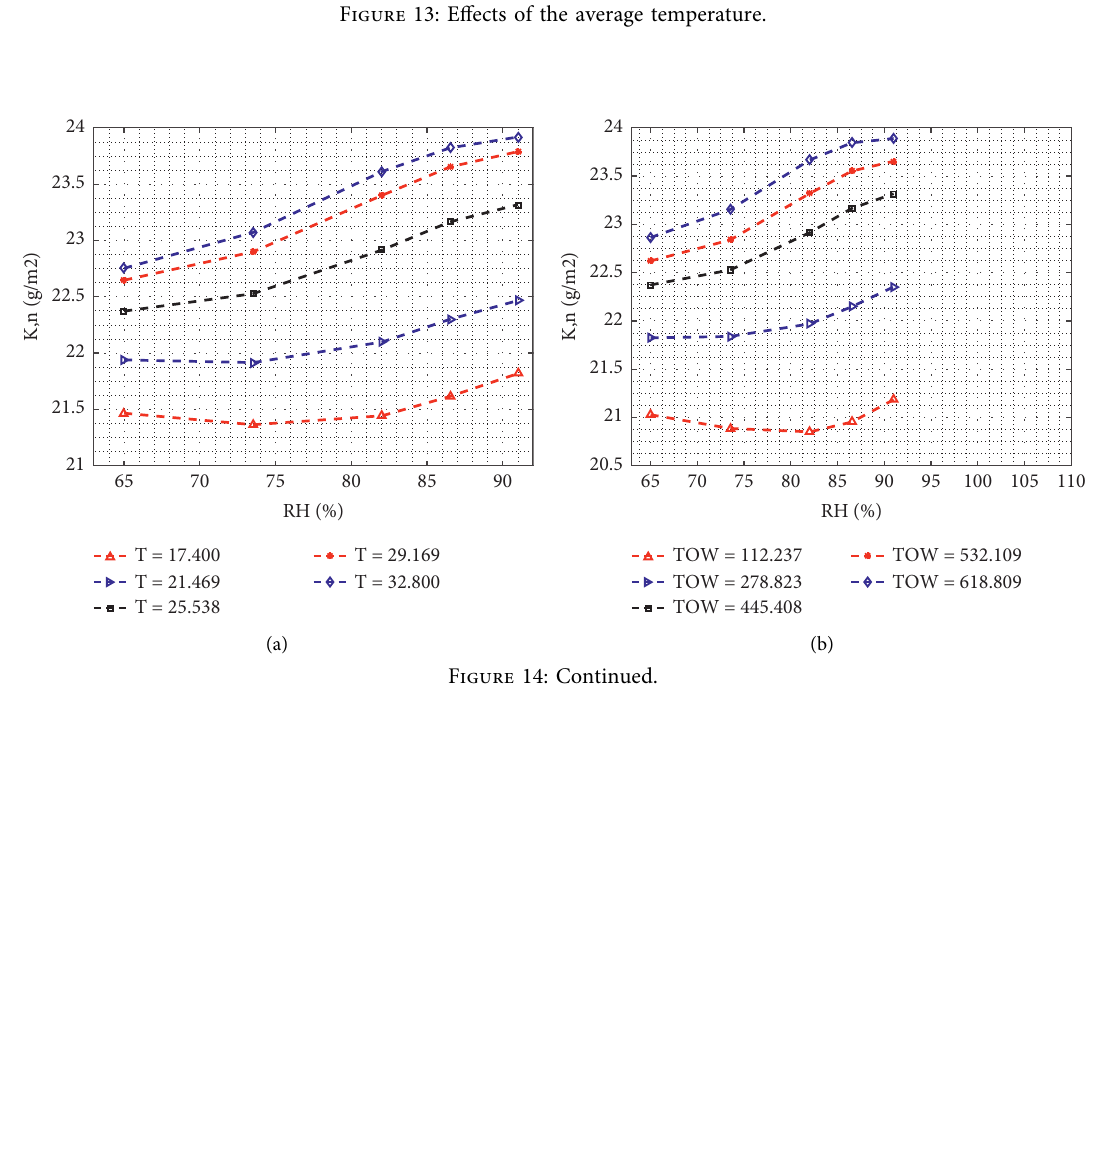
Figure 13: Effects of the average temperature.